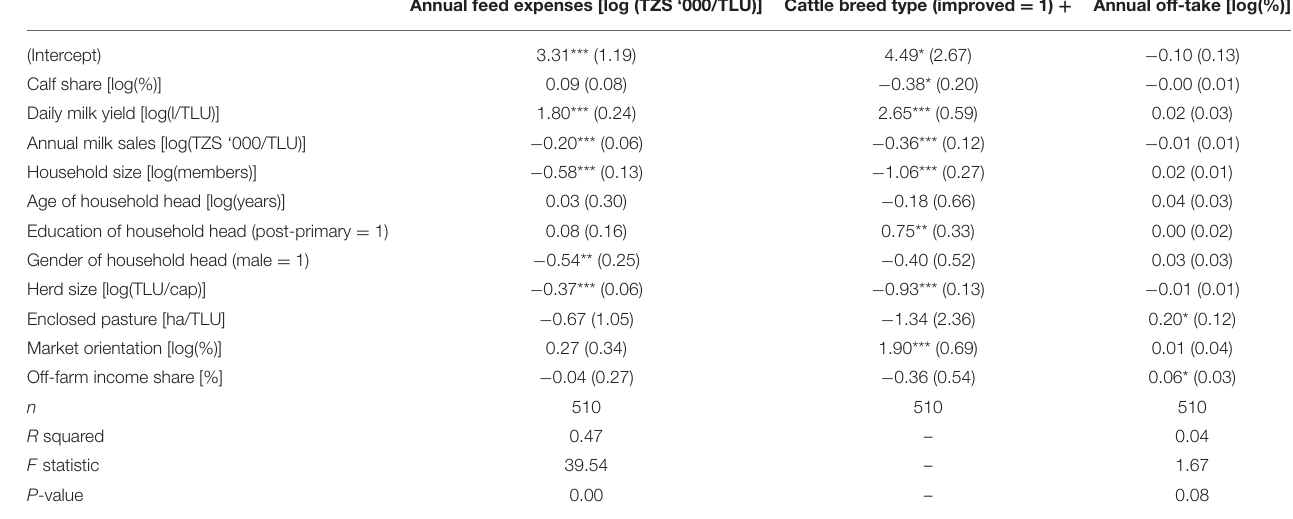
TABLE 8 | Association of herd productivity with farm management